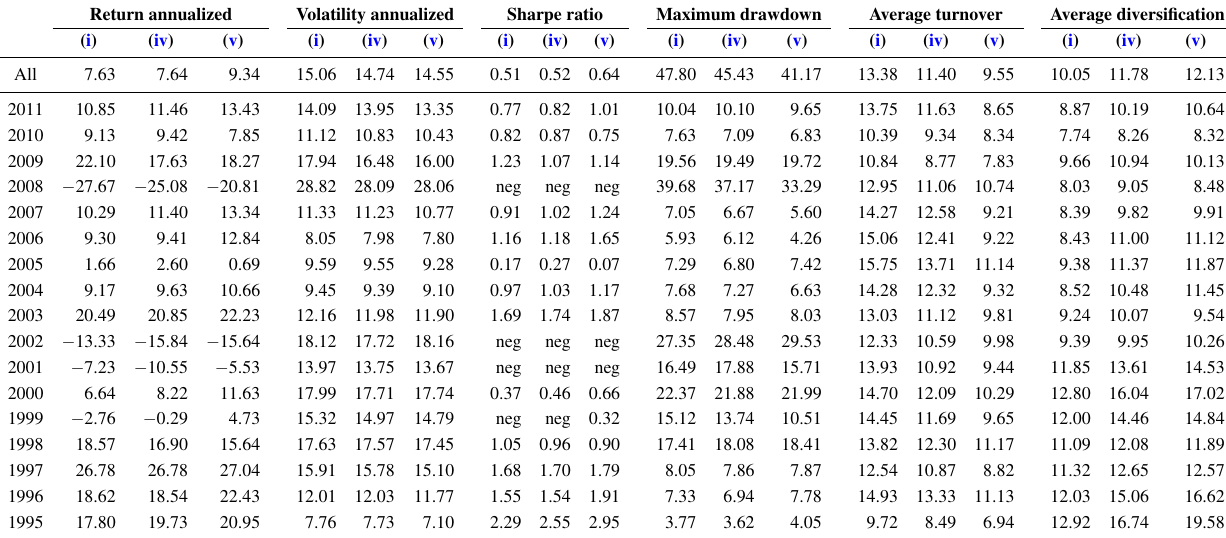
Out-of-sample backtesting results of the strategies